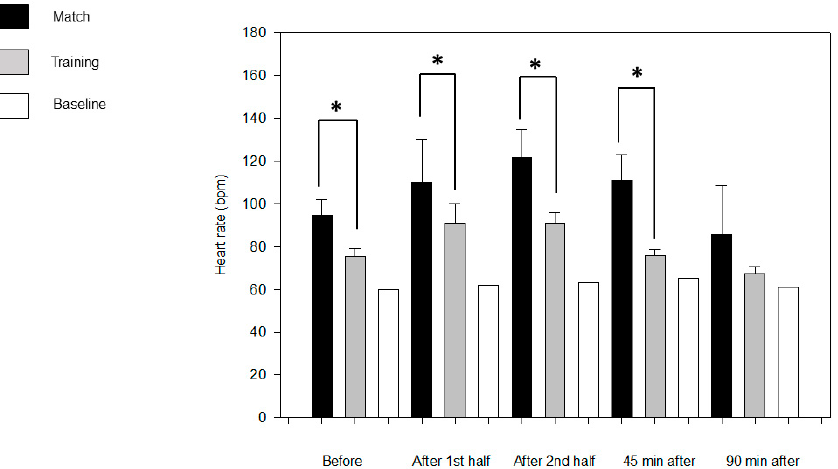
Figure 2. Heart rate (HR) values collected before, at halftime, directly after, and 45 and 90 min after, for the match, training, and the baseline with significant differences between match–training time points indicated with